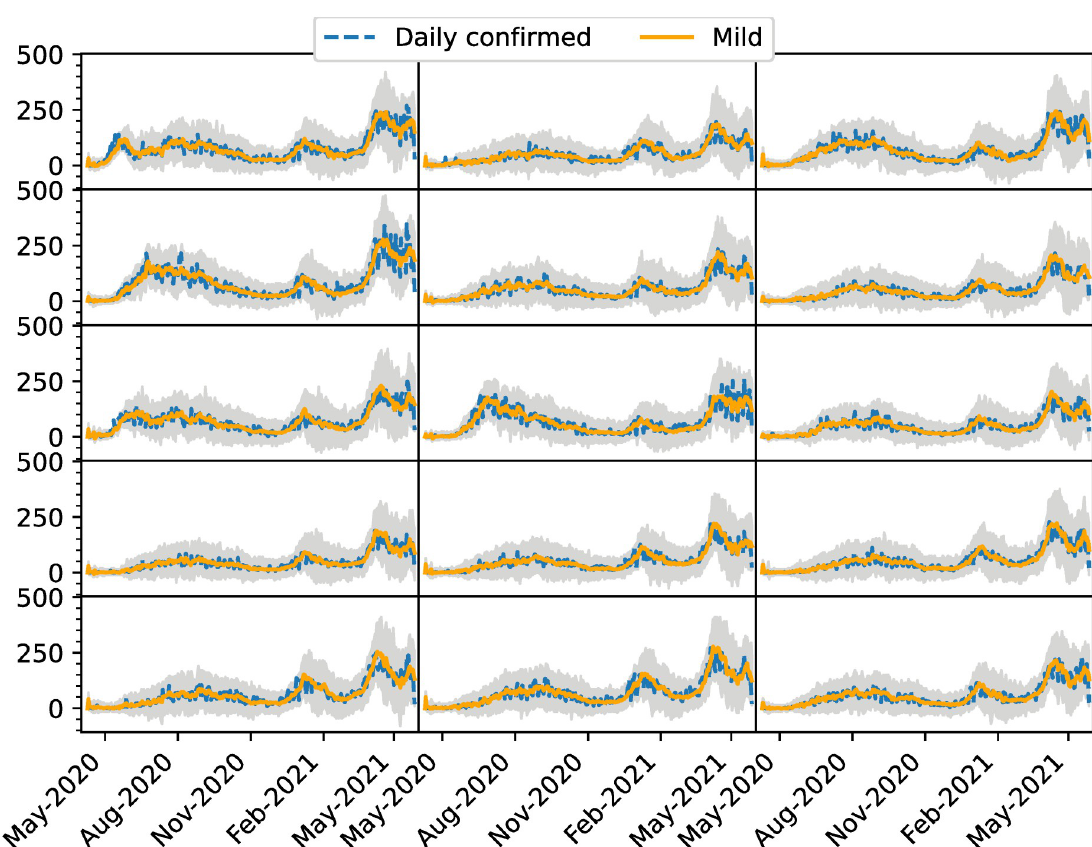
Fig 14. Daily new cases per commune. Each plot represents one of the 15 CABA communes. Estimated daily new cases are plotted with orange lines and the corresponding ensemble with gray lines. Blue dots correspond to the daily confirmed cases.